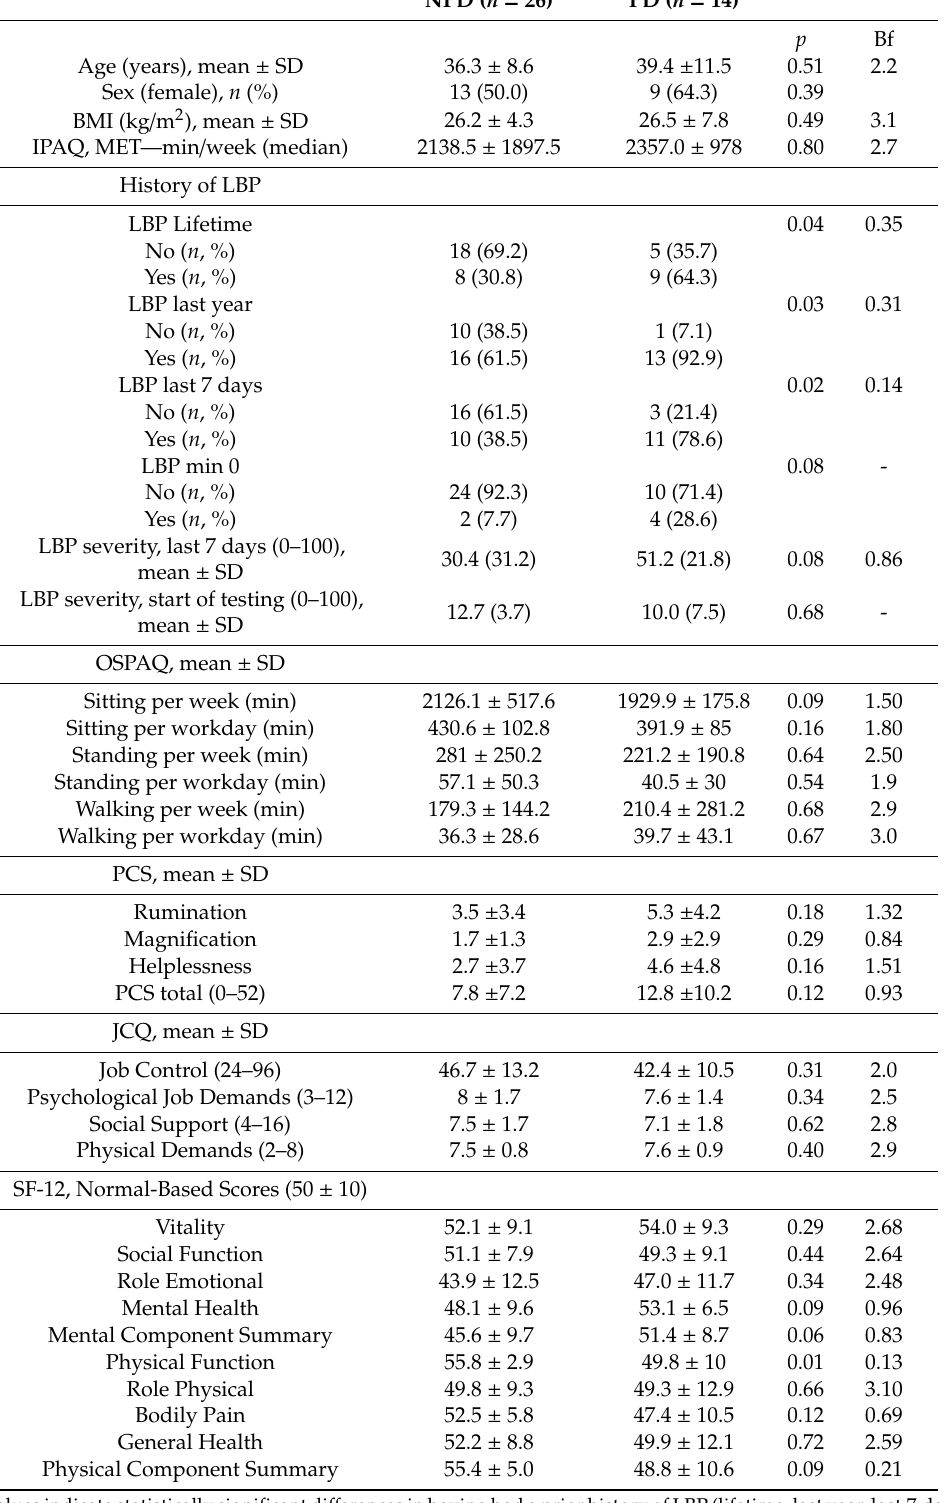
Table 1. Di ff erences in demographics and self-report measures for non-pain developers (NPD) and pain developers